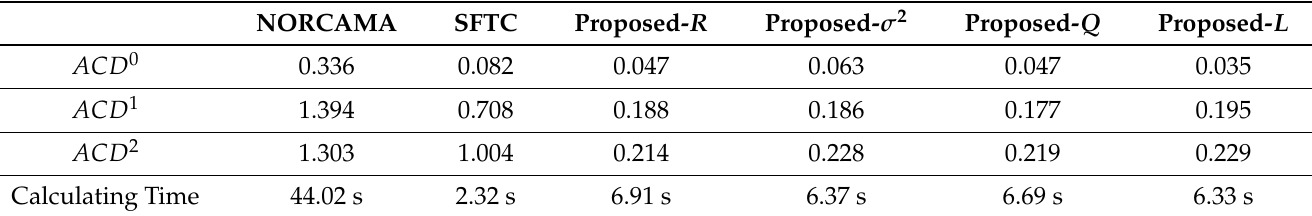
Table 4. Numerical results of the various methods using data 1.